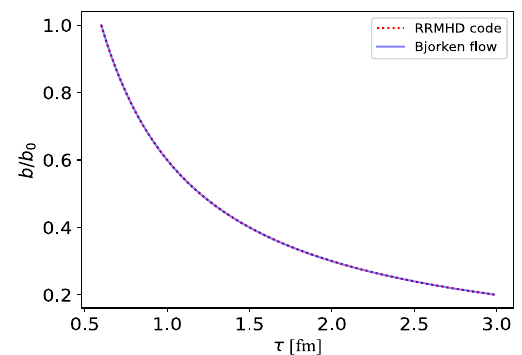
Fig. 15 The magnetic field strength as a function of τ is displayed in the magnetized Bjorken